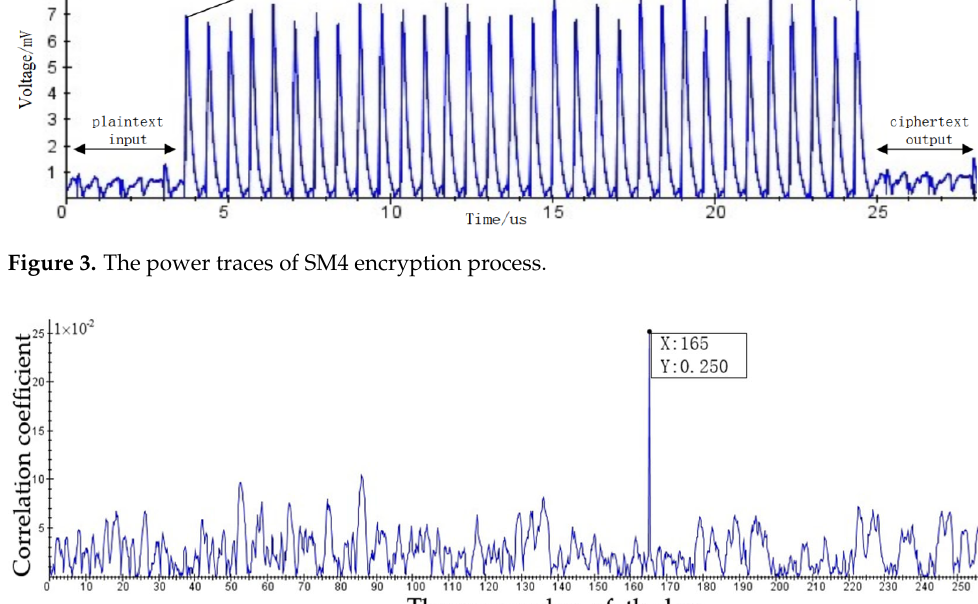
Figure 5. The second byte of 1 V CPA attack result. Figure 6. The third byte of 1 V CPA attack result.